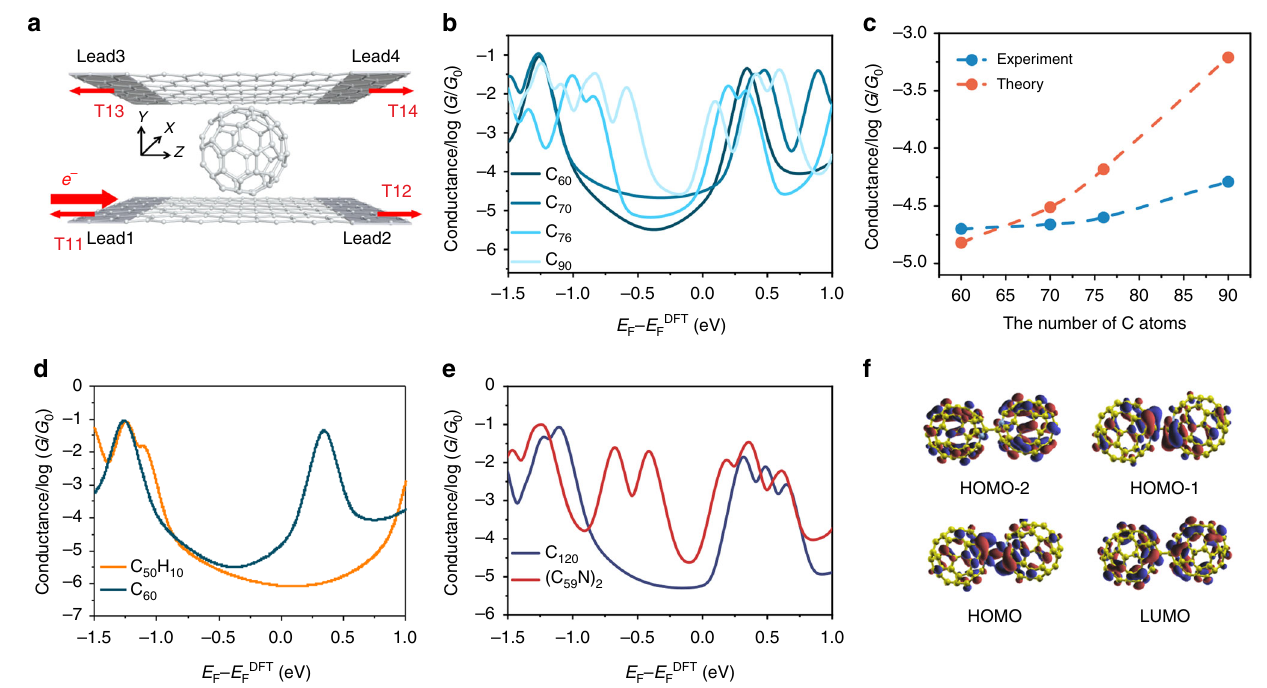
Fig. 4 Density functional theory (DFT)-based charge transport investigations. a Schematic design of the vertical junction. b Conductance spectra as a function of Fermi level. The four curves stand for the average conductance of C 60 , C 70 , C 76 , and C 90 over several different con fi gurations, weighted by a Boltzmann distribution. c Conductance variance with the increasing size of fullerene molecules. The four red dots depict the conductance evolution for the four molecules shown in b when the Fermi level is aligned with that given by DFT. d Conductance spectra as a function of Fermi level. The two curves stand for the average conductance of C 50 H 10 and C 60 over several different con fi gurations weighted by a Boltzmann factor. e Conductance spectra as a function of Fermi level. The two curves present the average conductance of C 120 and (C 59 N) 2 over several different con fi gurations weighted by a Boltzmann distribution. Highest occupied molecular orbital (HOMO)-2-, HOMO-1-, HOMO-, and lowest unoccupied molecular orbital (LUMO)-mediated resonances are speci fi ed for (C 59 N) 2 . f Frontier molecular orbitals of isolate molecule (C 59 N) 2 : HOMO-2, HOMO-1, HOMO, LUMO, which corresponds to the speci fi